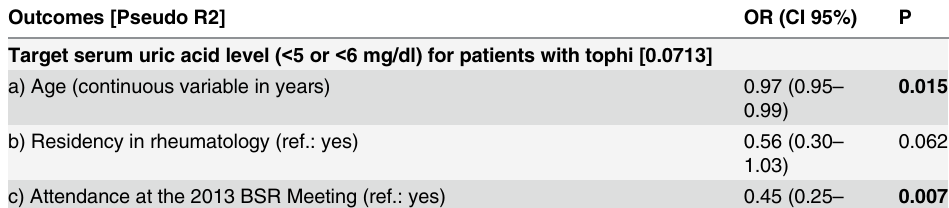
0.015 0.99) 0.062 1.03) 0.007 0.80)